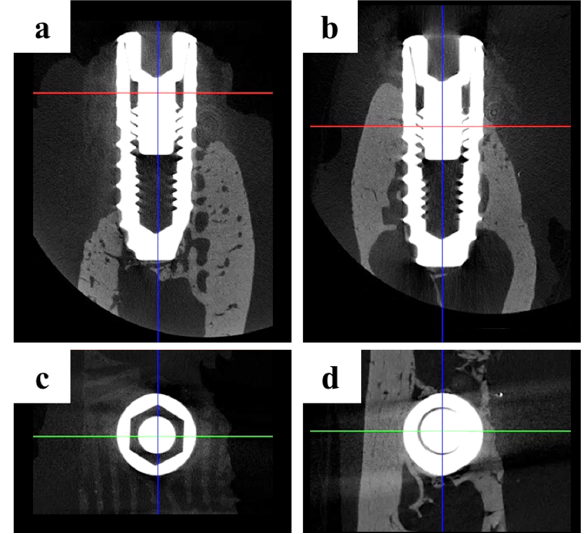
Figure 6. Micro-computed tomography (micro-CT) images: ( a , c ) Control group; ( b , d ) BMP group. ( a , b ) 3D reconstructed images of mesiodistal sections; ( c , d ) 3D reconstructed images of occlusal sections.